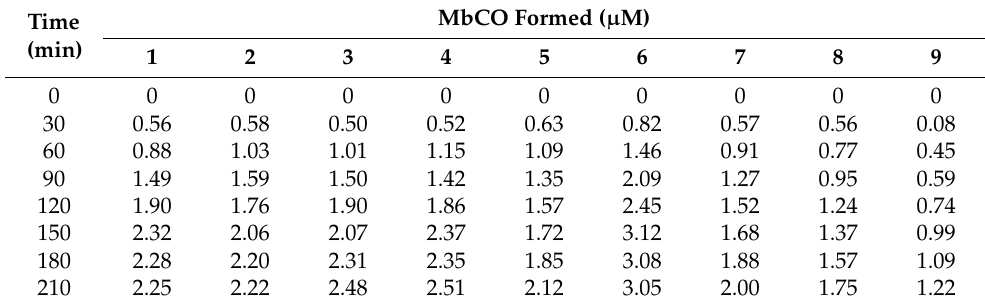
Table 1. MbCO formed at each time point when compounds 1 – 9 were analyzed at 1:6 CORM:Mb ratio.